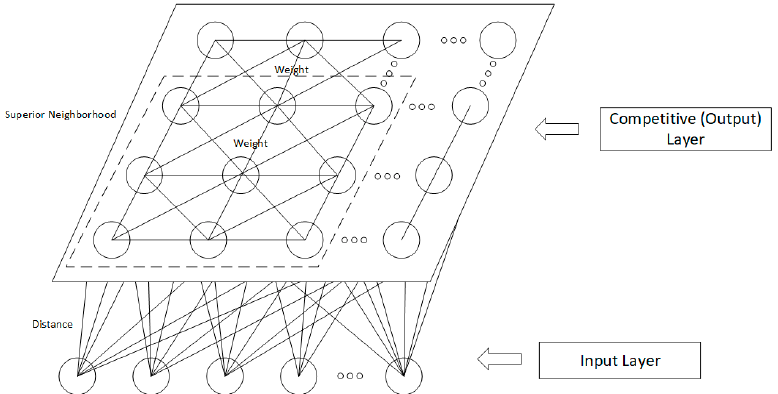
Figure 3. The structure of a self-organizing map (SOM) neural network.